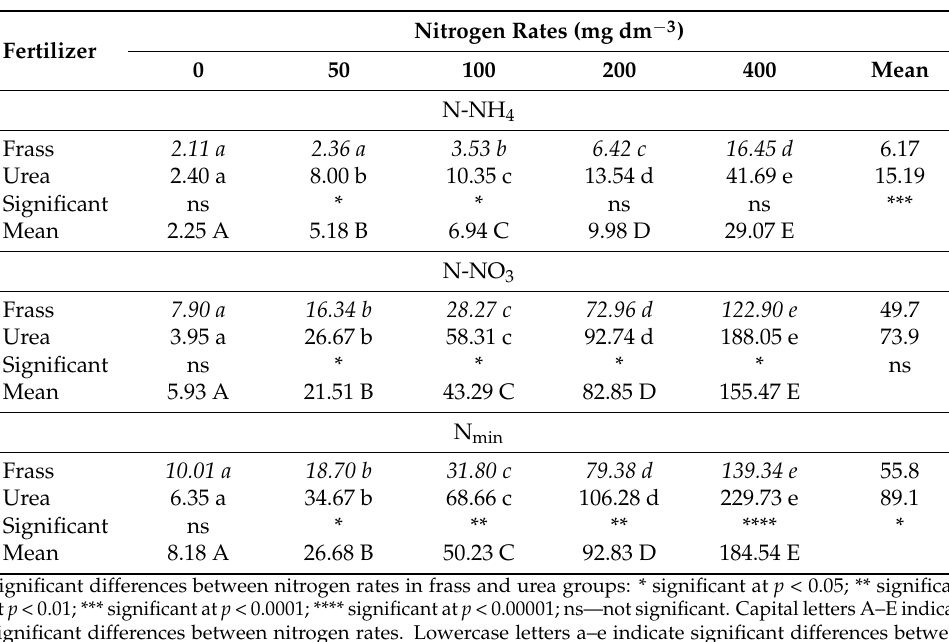
Figure 2. Changes in the content of N ‐ NO 3 in deacidified peat incubated with frass and urea. Differences are presented on a logarithmic scale.